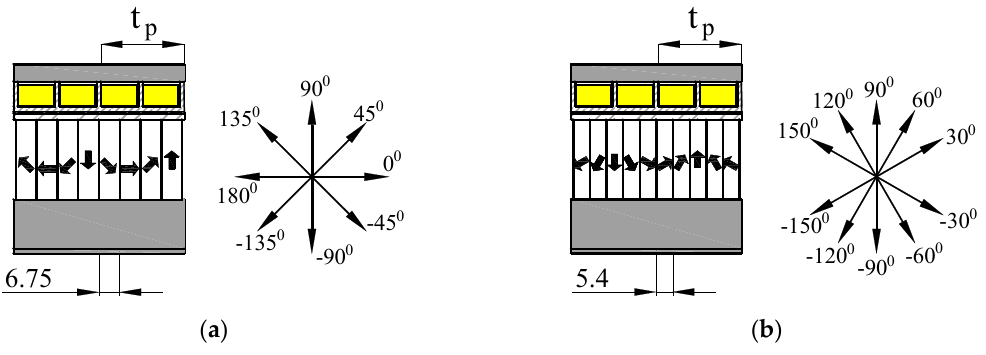
Figure 9. ( a ) 4-segment Halbach array; ( b ) 5-segment Halbach array. Table 2. Specifications of the magnet segments over one pole pitch.